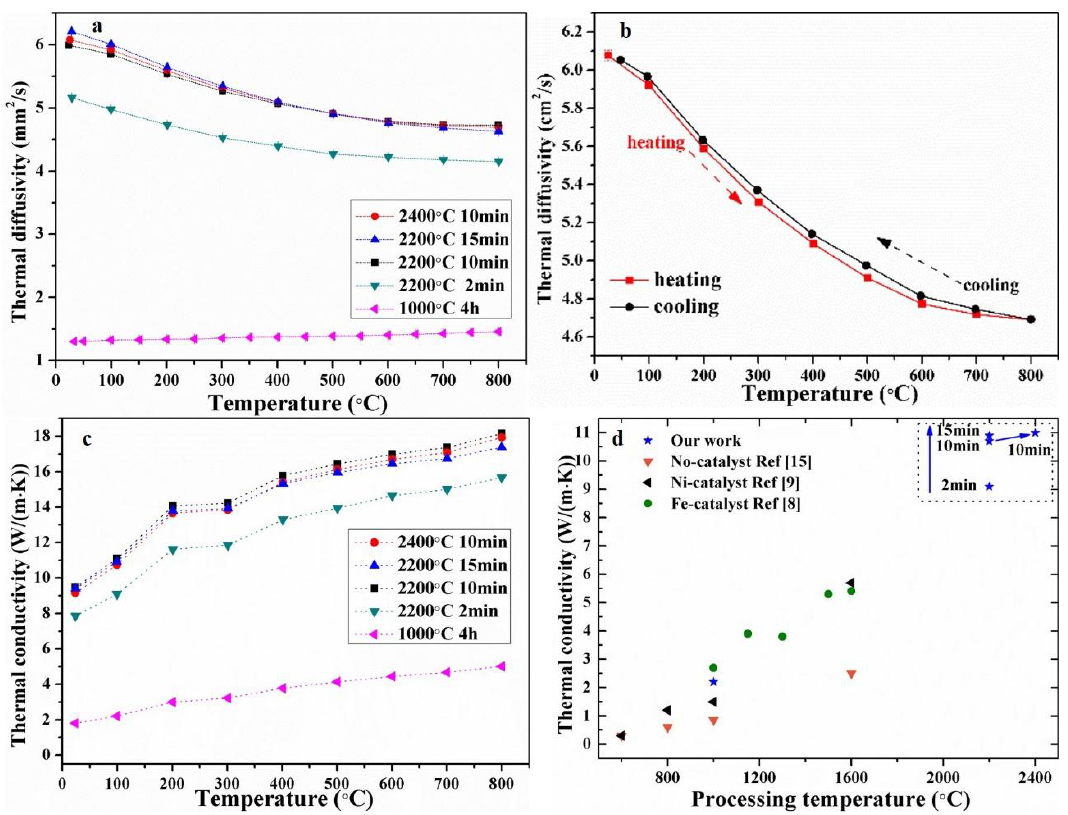
Figure 4. ( a ) Thermal diffusivity as a function of measuring temperatures for biocarbons obtained using different processing temperatures and dwell time; ( b ) Thermal diffusivity versus measuring temperatures during the heating and cooling process of the biocarbon prepared at 2400 °C for 10 min; ( c ) Thermal conductivity as a function of measuring temperatures for biocarbons; ( d ) Comparison of thermal conductivity (at 100 °C) of beech-derived biocarbons prepared using different techniques.